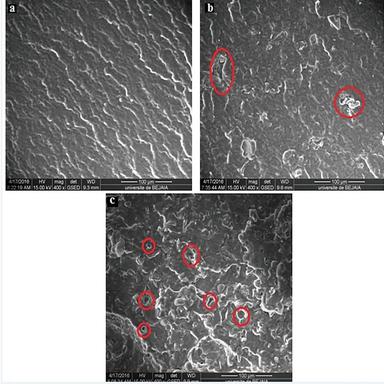
SEM micrographs. a) Virgin PCL, b) PCL/10% CP, c) PCL/30% CP.